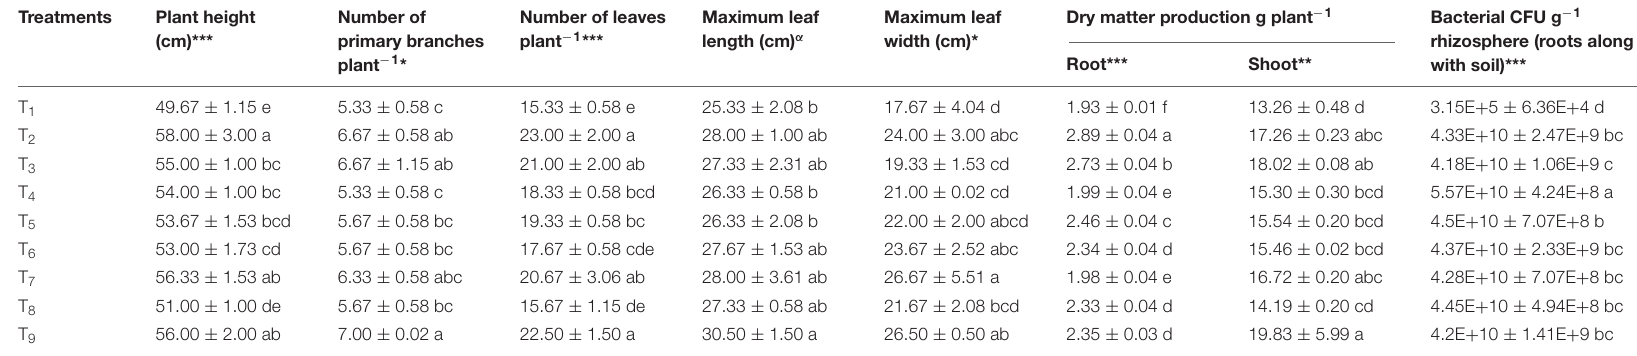
TABLE 5 | Growth of tomato plants and colonization of bacteria as influenced by inoculation of different biofilm-producing bacterial strains under water deficit-stressed conditions. Treatments